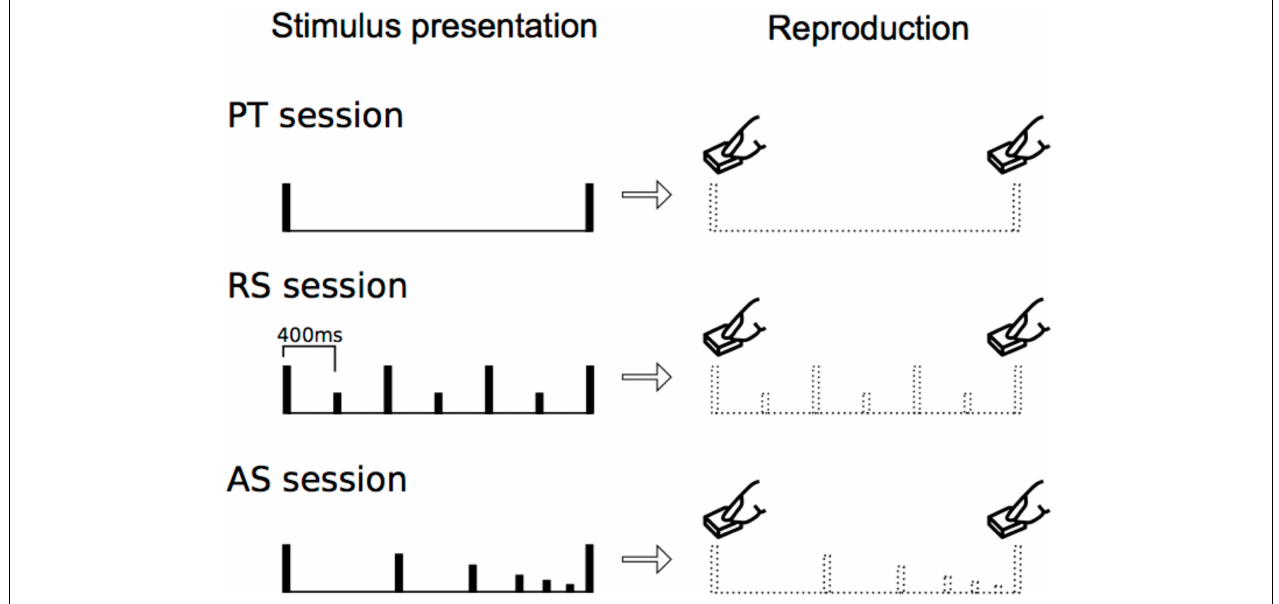
FIGURE 1 | Experimental procedure. In each trial, stimulus presentation was followed by reproduction. The participants reproduced the time interval between the first and the last stimuli that were presented most recently.